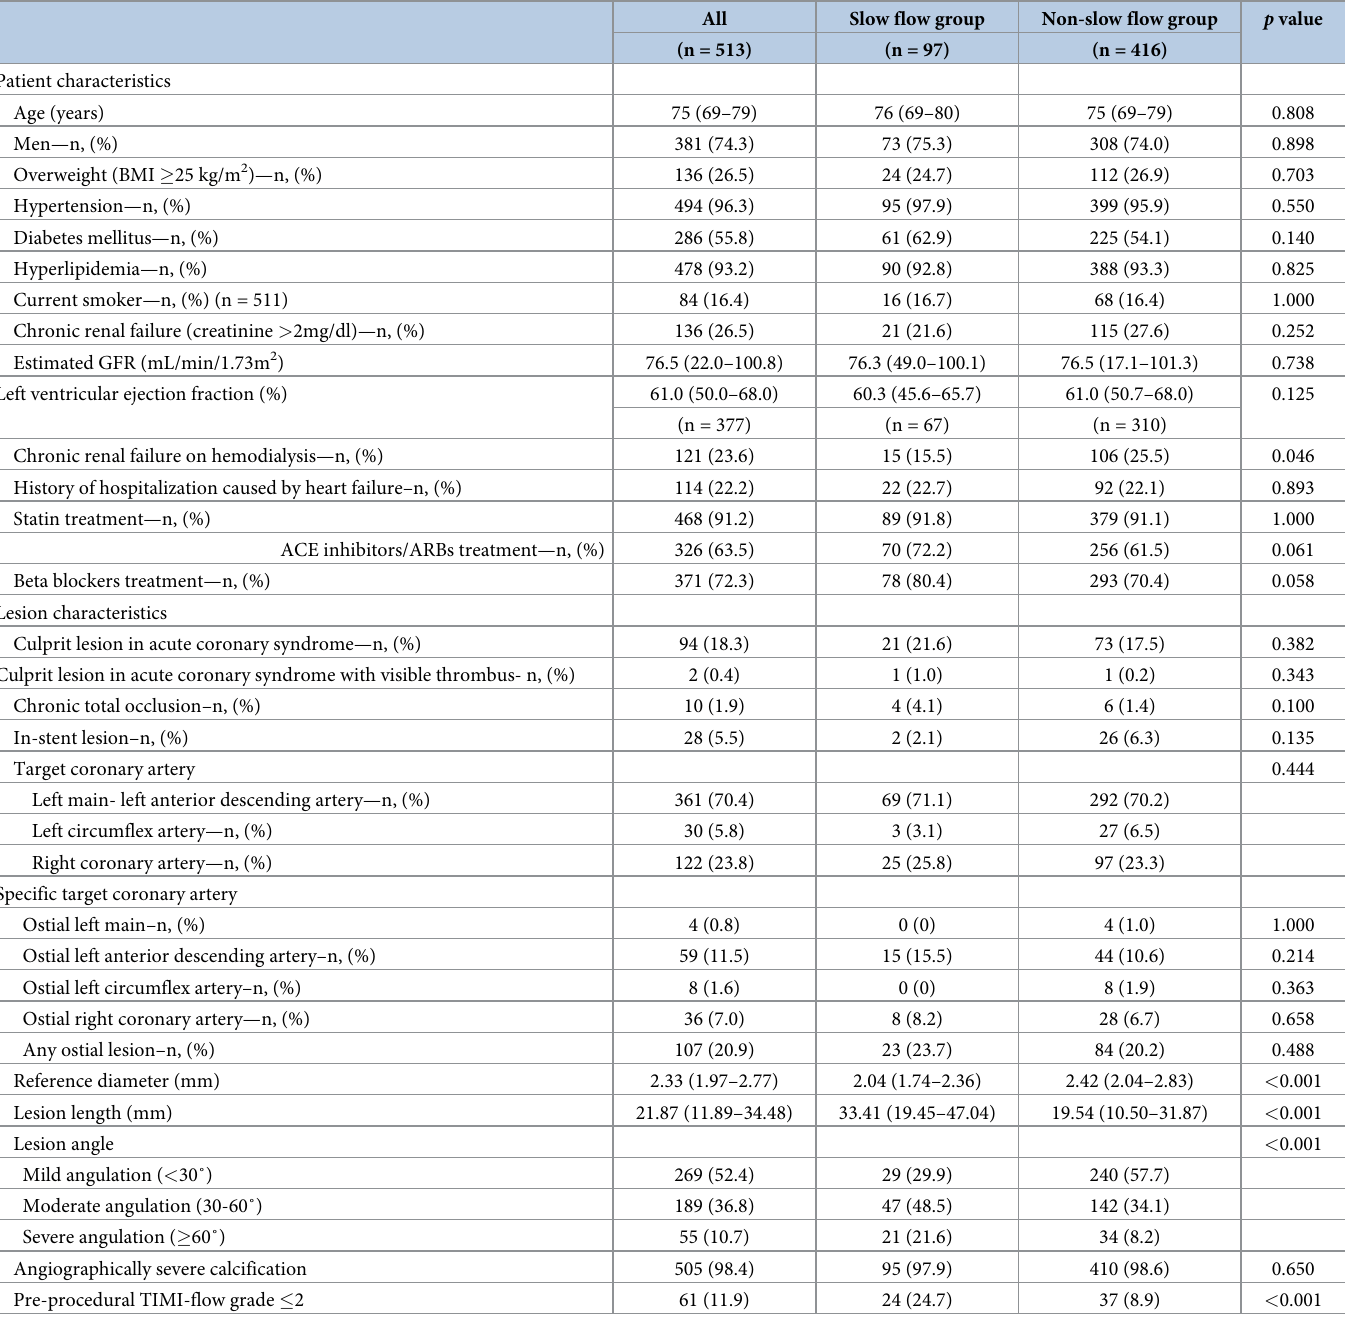
Table 1. Comparison of patients and lesions characteristics between the slow flow group and non-slow flow